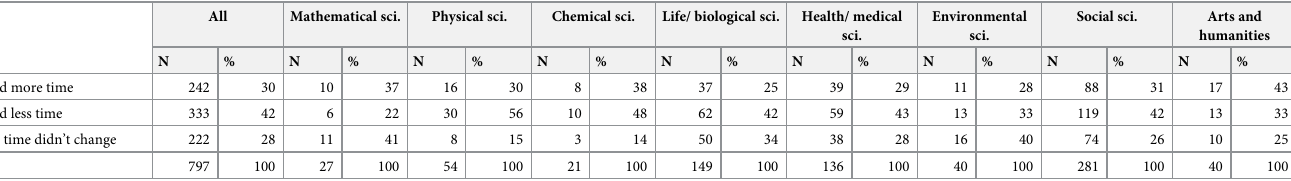
Table 4. What impact has the pandemic had on the time you allocated to research? All Mathematicalsci.